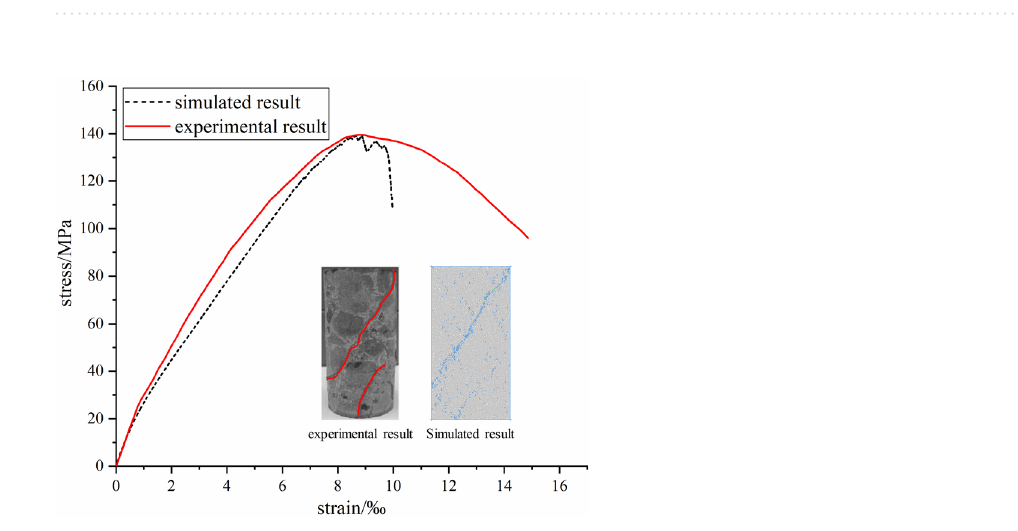
Figure 4. Test equipment and concrete samples.